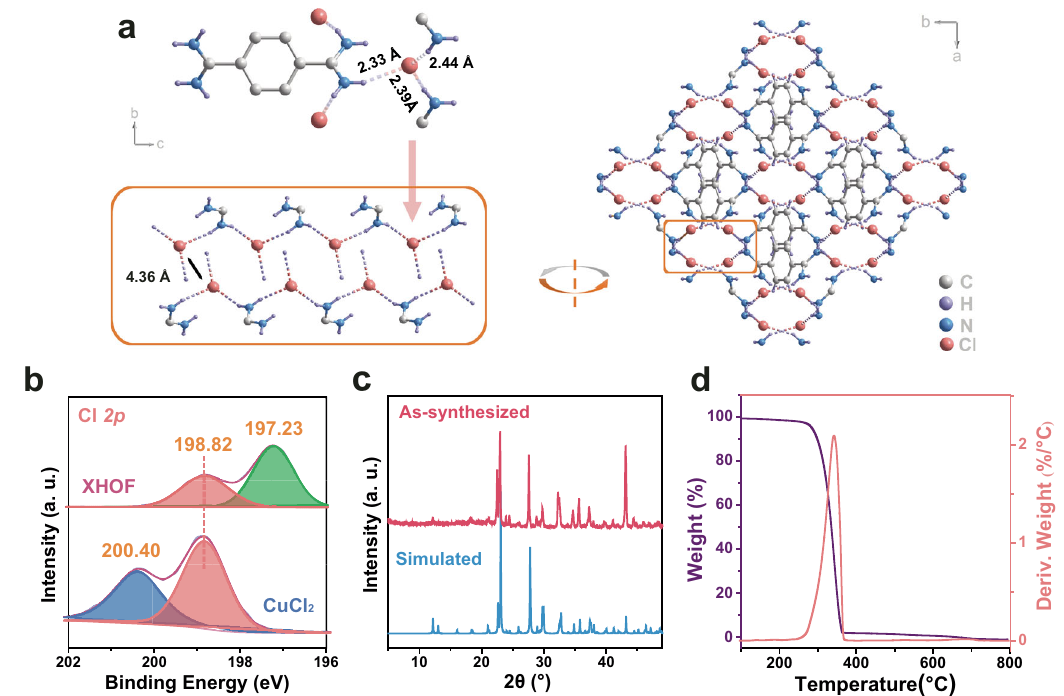
Fig. 3 Crystal structure and characterization of the materials. a Crystal structure of XHOF-TAQ. b High-resolution XPS for Cl. c The simulated and as- synthesized PXRD patterns for XHOF-TAQ. d TGA analysis of